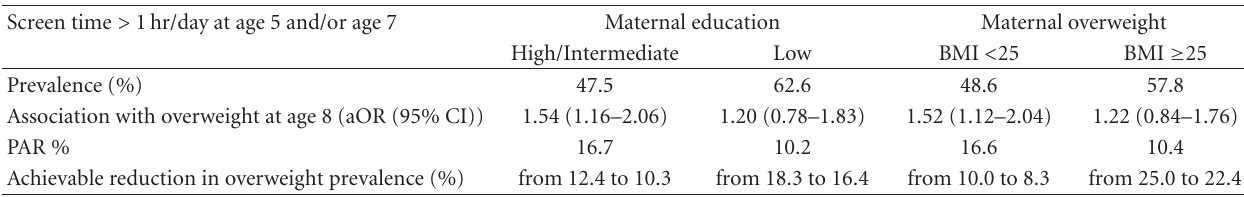
Table 5: Screen time > 1hr/day at age 5 and/or age 7, stratified by maternal education and by maternal overweight: Prevalence; association with overweight (incl. obesity) at age 8 (with < 1hr/day at ages 5 and 7 as the reference); adjusted 1 Population Attributable Risk (PAR%); achievable reduction in overweight prevalence if risk factor was